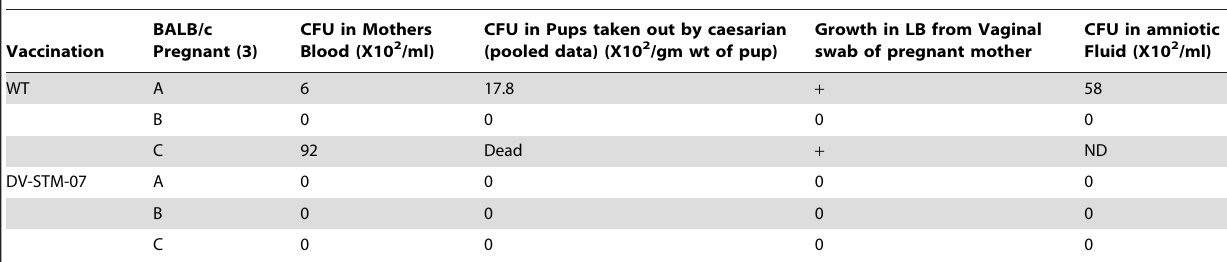
Table 3. Transmission profile of bacteria during pregnancy in control and vaccinated mice.